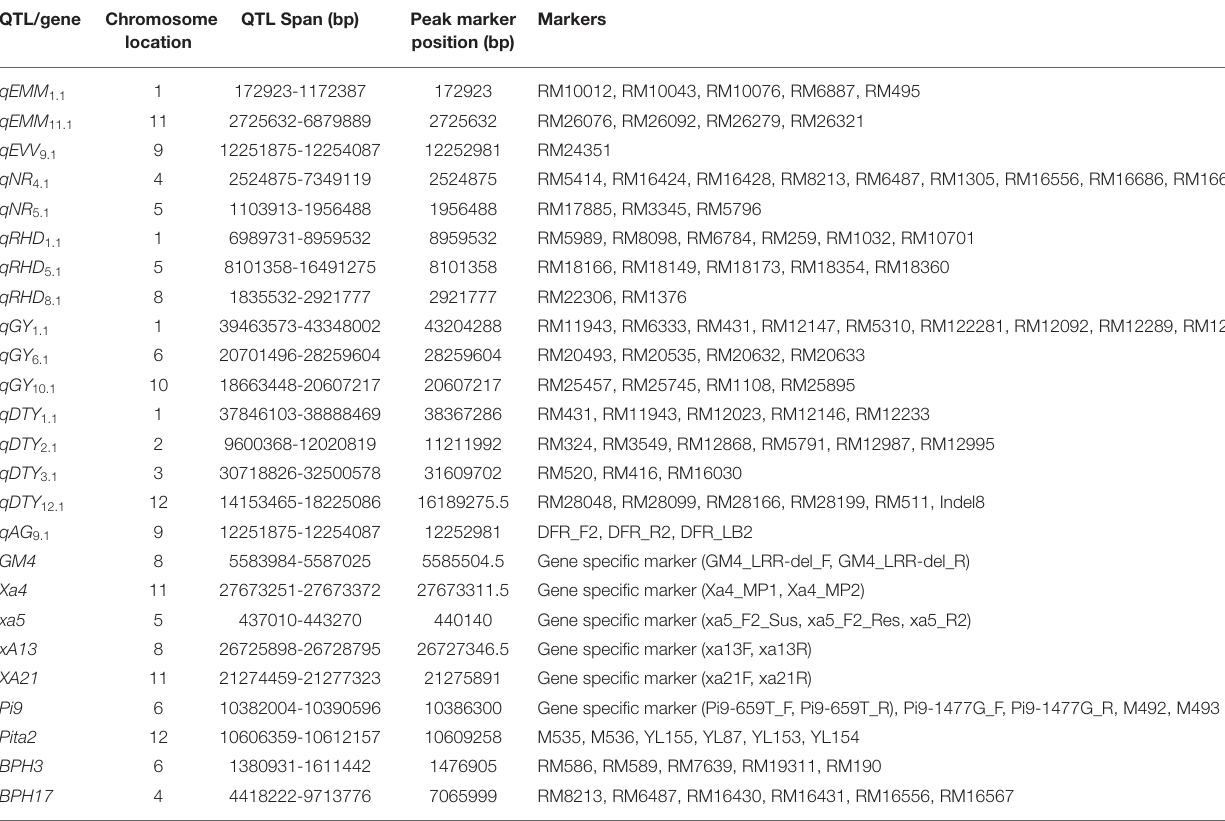
TABLE 3 | Detailed information on the SSR/InDel/gene-specific markers used in the genomics-assisted introgression study. QTL/gene Chromosome location